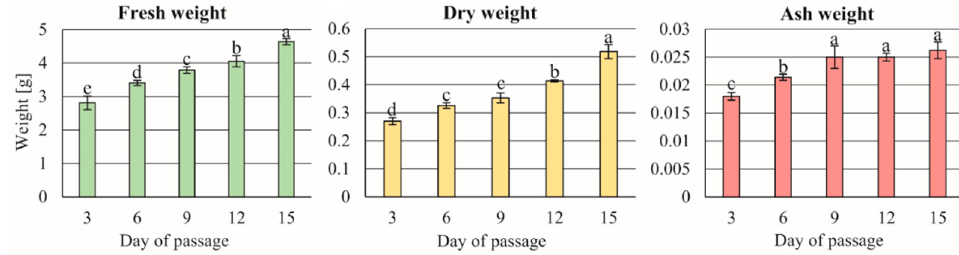
Figure 7. The kinetic of the growth of the cell suspension in a standard culture of liquid ½ MS me- dium supplemented with 9.05 µM 2,4-D + 0.88 µM BAP and 20.0 g/L sucrose.